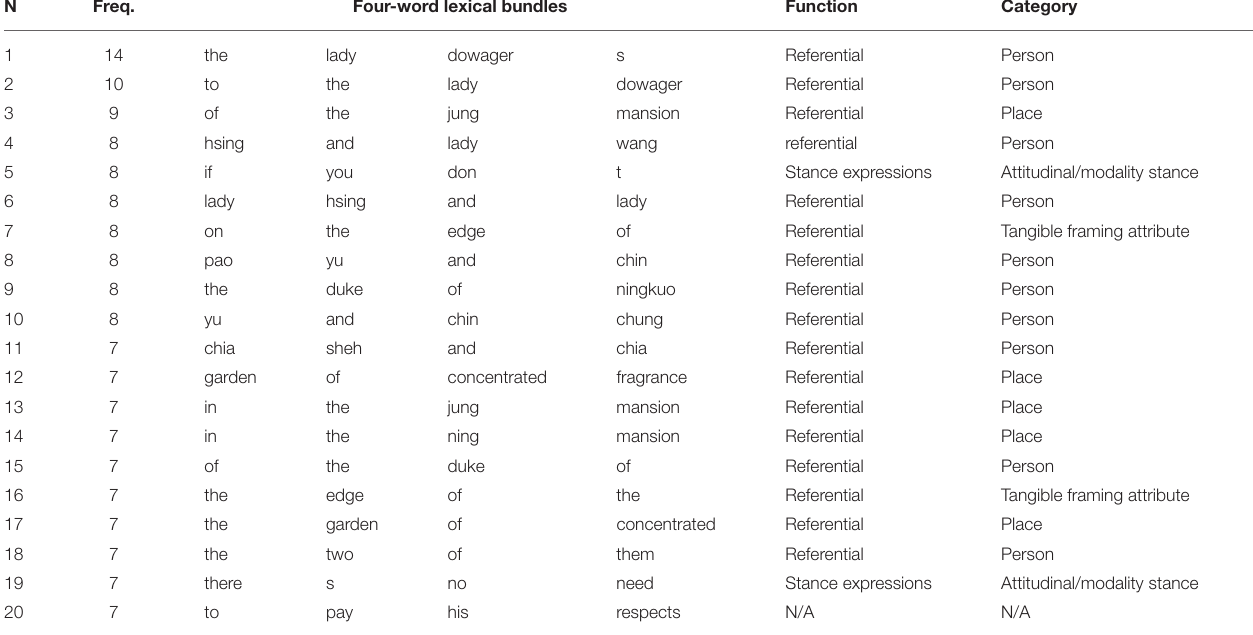
TABLE 5 | Top 20 most frequent four-word lexical bundles in Yangs. N